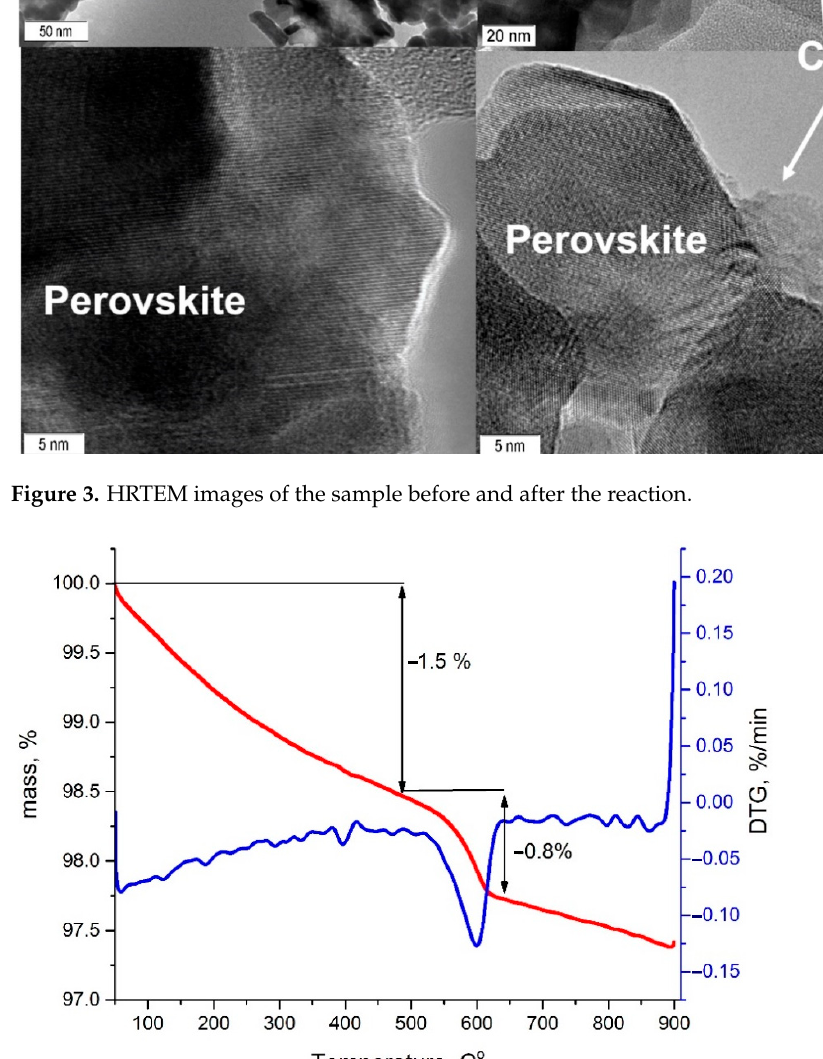
Figure 4. Thermogravimetric curve of La 0.5 Ca 0.5 Mn 0.5 Co 0.5 O 3 in the He flow.